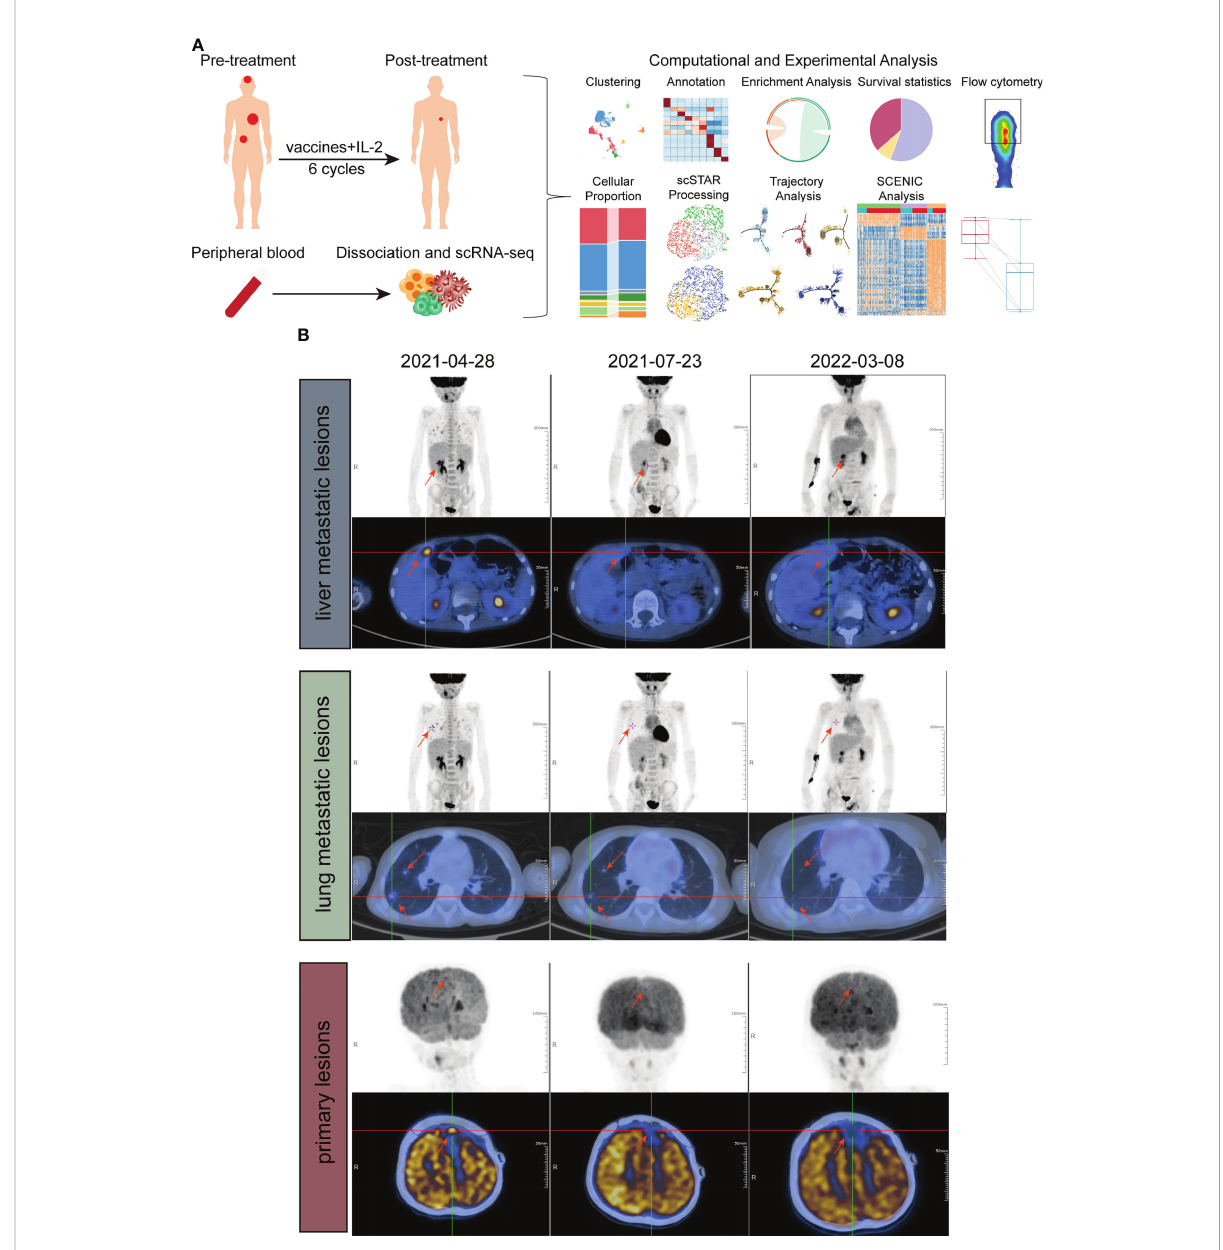
FIGURE 1 Study design and examinations of patients in different periods. (A) Schematic of the experimental design and analytical work. (B) PET/CT imaging of liver metastatic lesions (above), lung metastatic lesions (middle) and primary lesion (down) at three timepoints, before treatment, approximately 6 weeks after treatment and approximately 1 year after